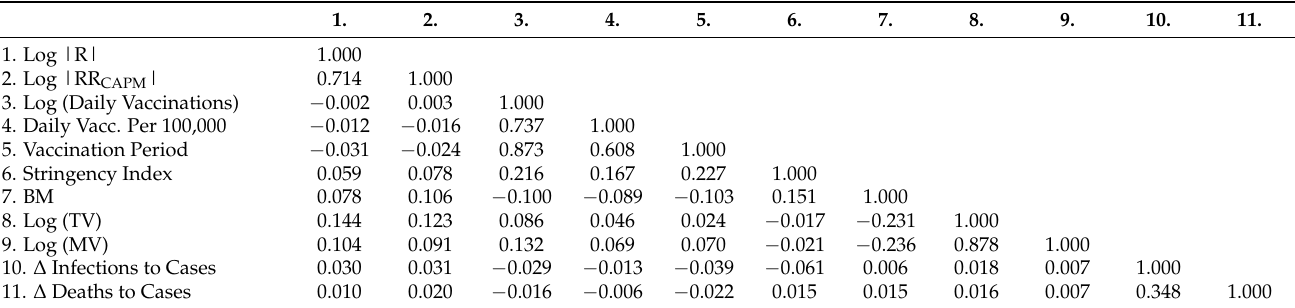
Table 3. Correlation coefficients between the major